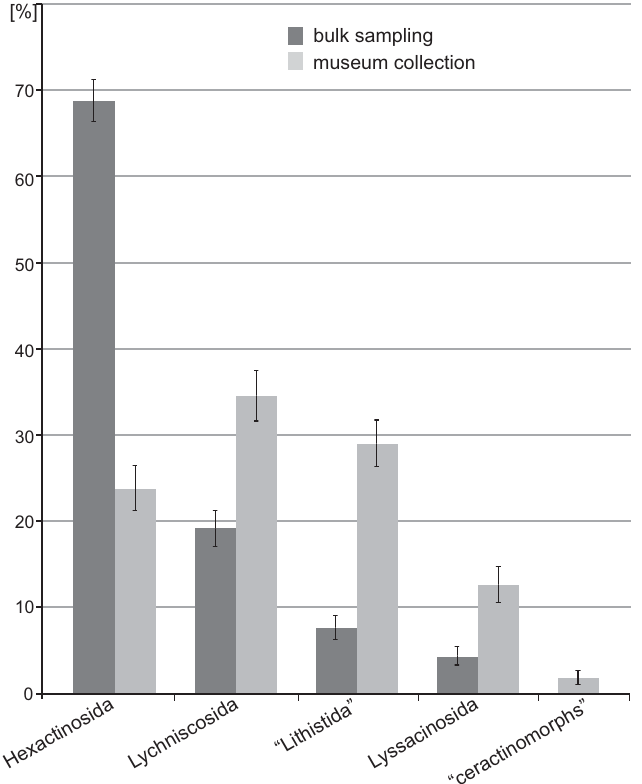
Fig. 6. Comparison between frequency of museum collections (data from Frisone et al. 2016) and bulk field sampling (this study) at the ordinal level. Error bars denote binomial standard errors of